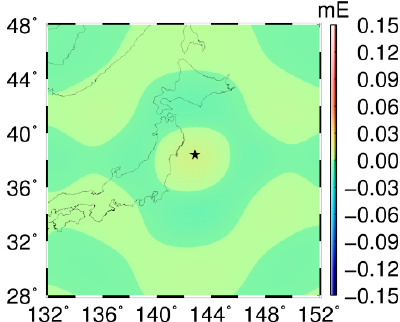
Figure 7. Radial gravity gradient changes ( Δ V zz ) in Local North-Oriented Frame on a sphere with a height of 260 km computed by the tailored spherical harmonic coefficients from the viscoelastic relaxation model with a Gaussian filter applied. The SH degree range is 30–95 and the radius of the filter is 210 km. The units are mE.